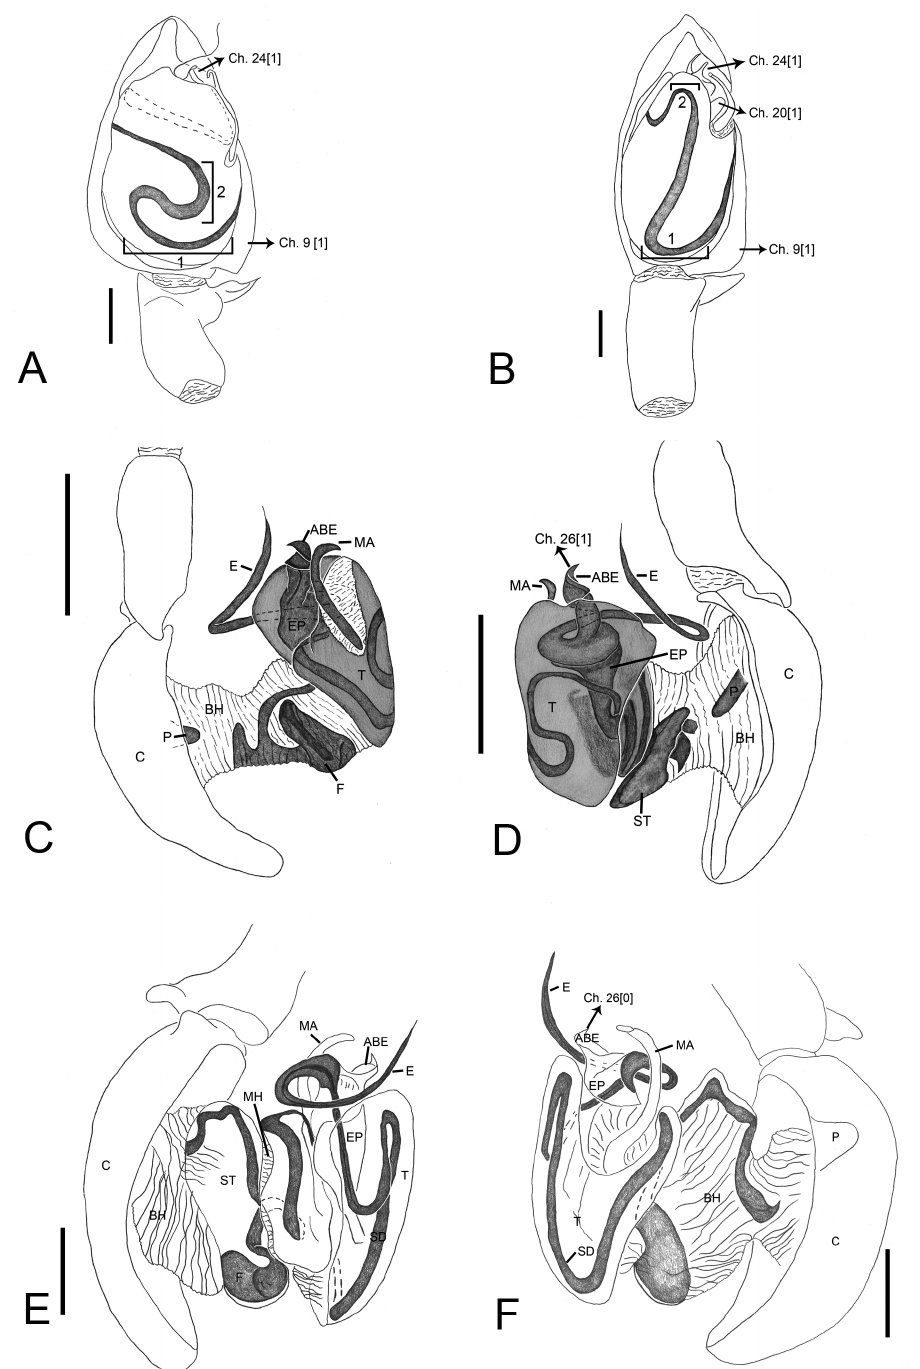
Fig. 9. A, C–D . Tafana silhavyi (Caporiacco, 1955), ♂ (MNHN 11312). A . Left palp unexpanded, ventral view (arrow indicating character). C . Left palp expanded, prolateral view. D . Left palp expanded, retrolateral view (arrow indicating character). B . Tafana riveti (MCZ), ♂, left palp. E–F . Tafana riveti (MCZ), ♂. E . Left palp, retrolateral view. F . Left palp, prolateral view (arrow indicating character). Abbreviations: 1 = primary loop of the sperm duct; 2 = secondary loop of the sperm duct; ABE = apophysis of base of the embolus; BH = basal haematodocha; C = cymbium; Ch = character; E = embolus; EP = embolic process; F = fundus; MA = median apophysis; MH = median haematodocha; P = petiole; SD = sperm duct; ST = subtegulum; T = tegulum. Scale bars: A–B, E–F = 0.25 mm; C–D = 0.5